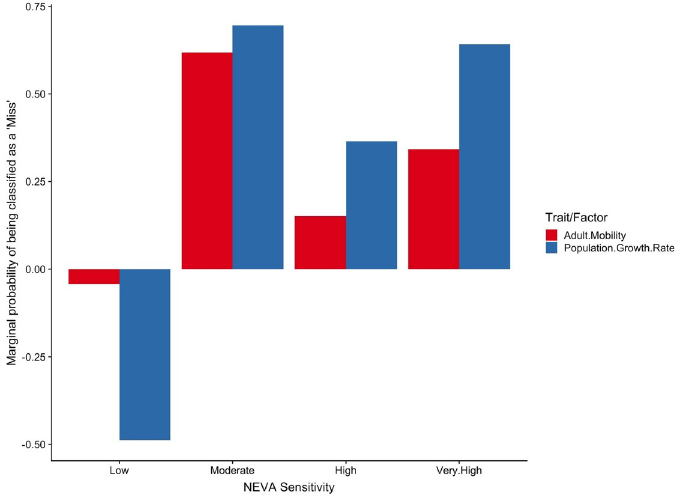
Fig 11. Partial importance plot from fitted Random Forest model classifying match/mismatch in sensitivity ranking between quantitative SDM and qualitative expert assessments. The plot shows the marginal probability of being classified as a “miss” given the NEVA sensitivity ranking for the two most important traits/factors influencing the accuracy of the Random Forest model.